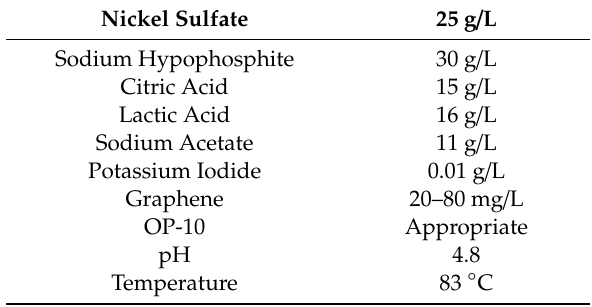
Table 1. The electroless bath solution composition and operating